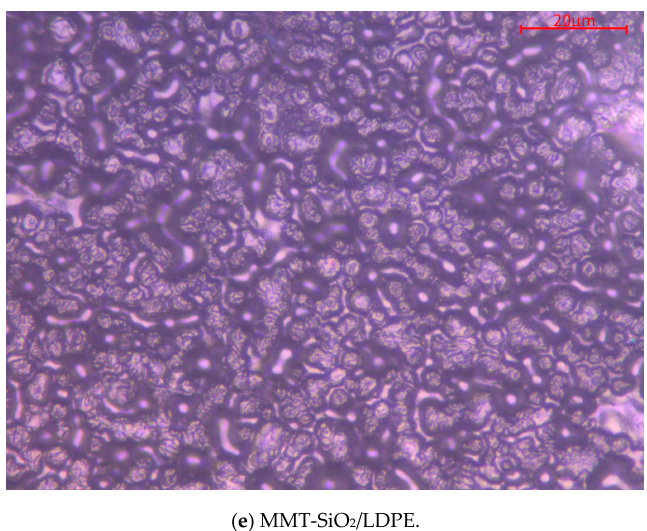
Figure 3. The crystalline morphology of LDPE and composites after etching observed under microscope. ( a ) PLM image of LDPE; ( b ) PLM image of MMT / LDPE; ( c ) PLM image of SiO 2 / LDPE; ( d ) polarizing microscope. ( a ) PLM image of LDPE; ( b ) PLM image of MMT/LDPE; ( c ) PLM image of PLM image of SiO 2 -MMT / LDPE; ( e ) PLM image of MMT-SiO 2 / SiO 2 /LDPE; ( d ) PLM image of SiO 2 -MMT/LDPE; ( e ) PLM image of MMT-SiO 2 /LDPE.